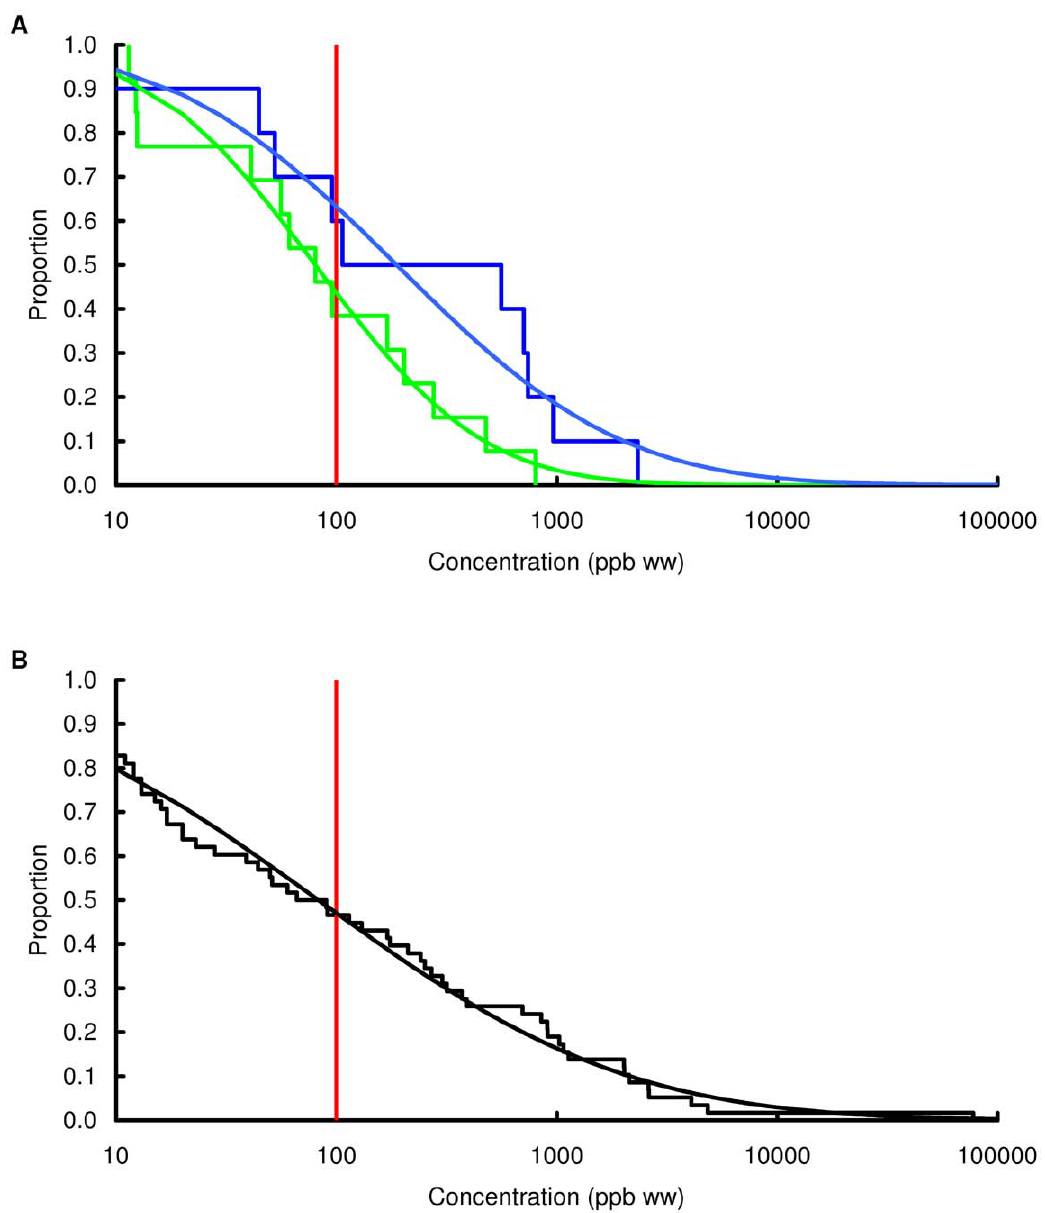
Figure 5. Exceedance distribution of lead concentrations in pheasant from the WWT and VMD studies. Observed (stepped line) and fitted (curve) exceedance distribution of lead concentrations (ppb wet weight) in pheasant (A) cooked using acidic (green) and non-acidic (blue) methods and (B) fresh uncooked tissue from the VMD statutory surveillance programme. The curves represent lognormal distributions fitted to all the data, including those below the limit of quantification, by a maximum-likelihood method involving left-censoring at the LOQ. The red vertical line shows the statutory maximum residue level (MRL) for poultry and other non-game meat.